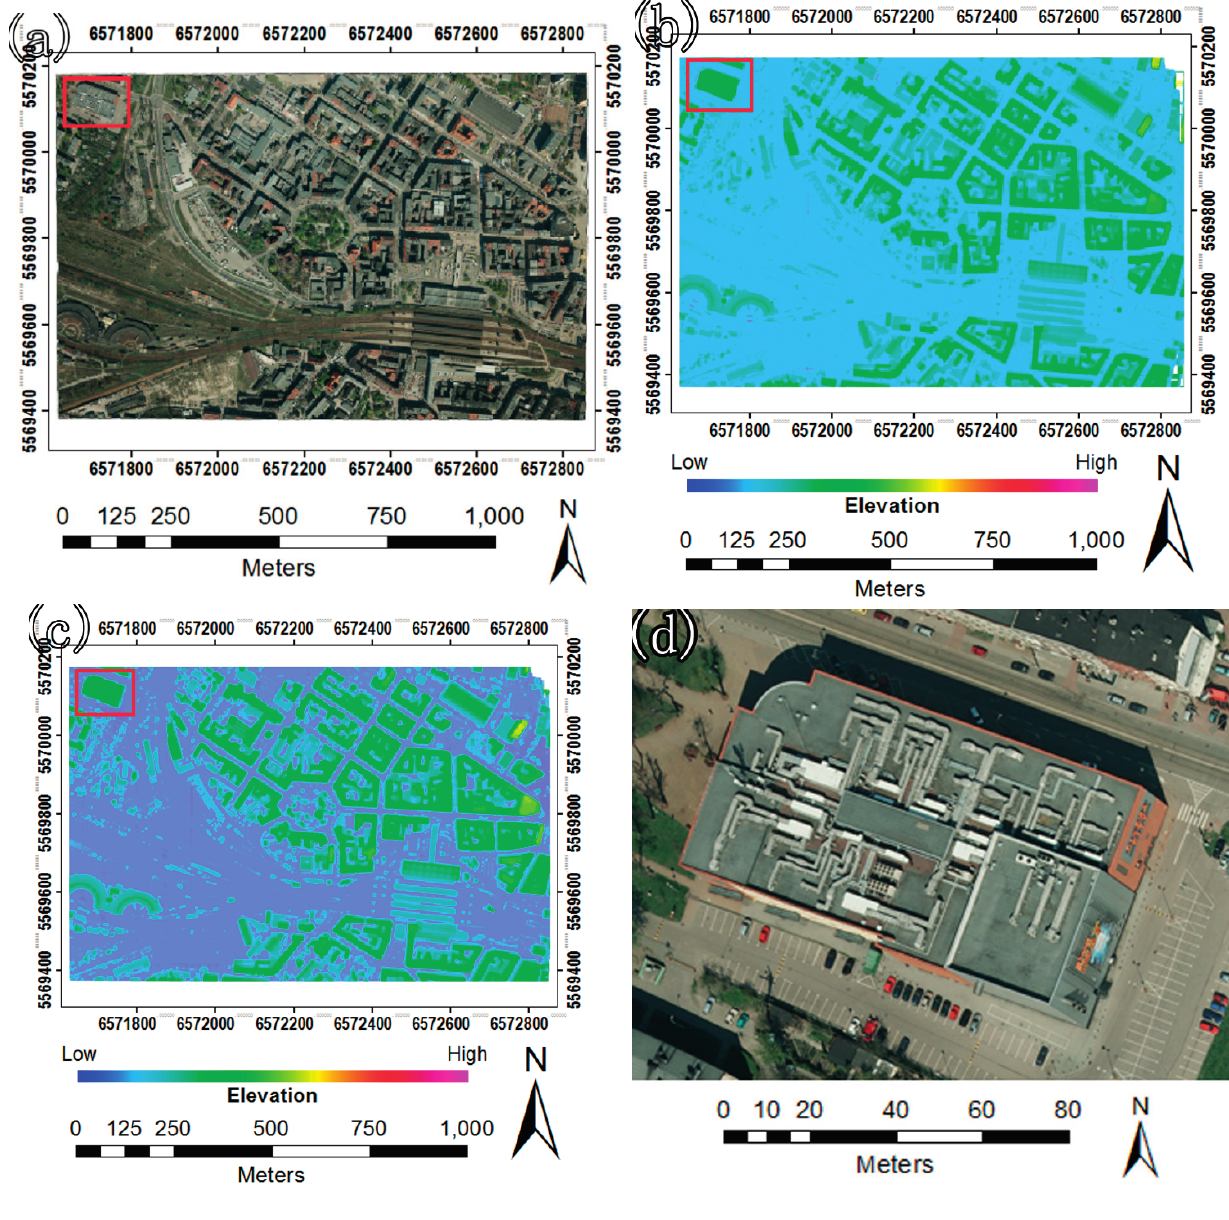
Figure 4. Overlying views between a DOM and the elevation contours of a DSM or OESM. ( a – c ) The DOM and the elevation renderings of the normalized DSM and OESM in the same area, respectively; ( d ) the image in the red rectangular area; and ( e , f ) the overlying views between a DOM and the elevation contours of a DSM or OESM in the red rectangular area,